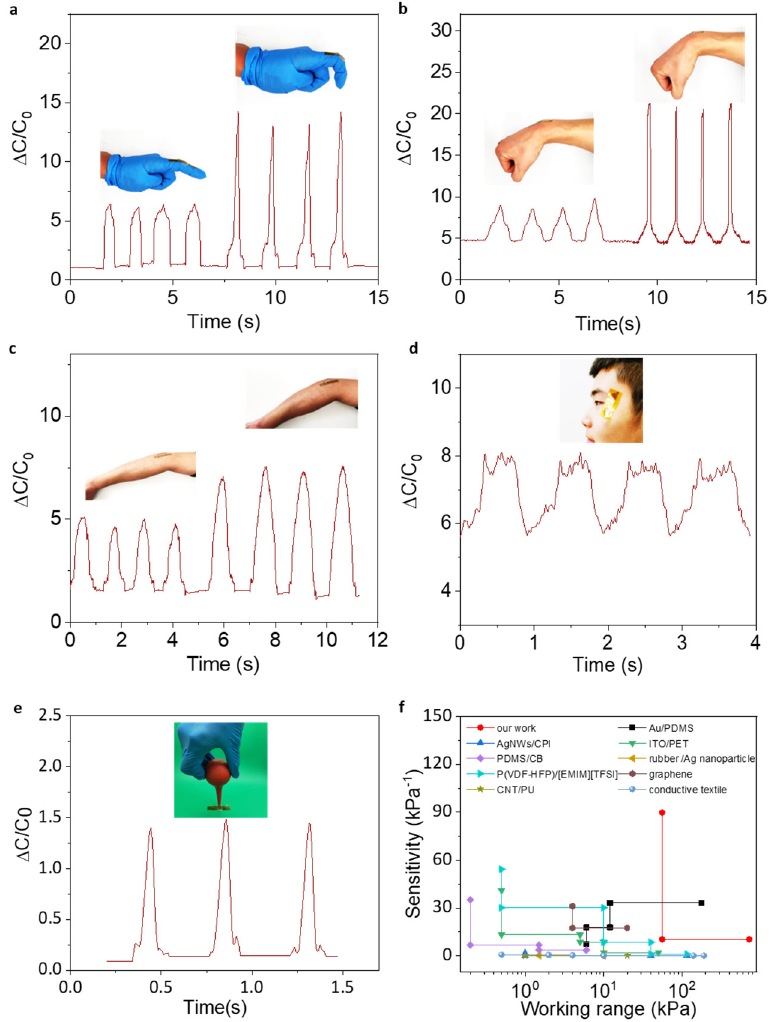
Figure 7. Practical application of the flexible iontronic sensor for montion monitoring. Capacitance variations of the sensor during ( a ) finger ( b ) wrist ( c ) arm bending and ( d ) eye blinking. ( e ) Capaci- tance response output of gas leak monitoring, and the image is shown in the inset. ( f ) Comparison of the sensitivity of our pressure sensor with existing capacitive